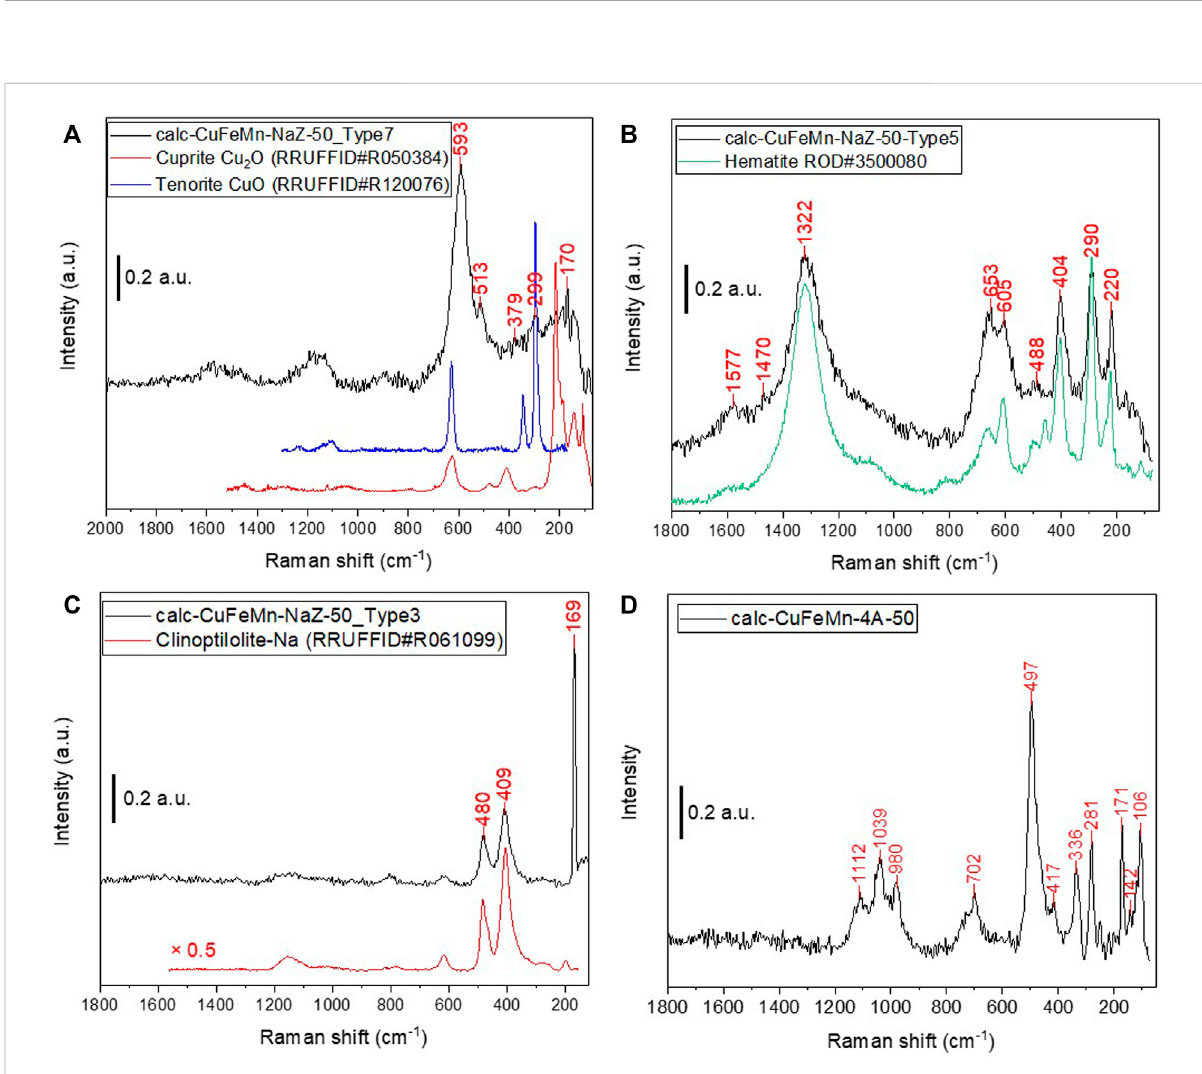
FIGURE 6 Raman spectra of sample calc-CuFeMnNaZ-150 (A,B and C) and sample calc-CuFeMn-4A-50 (D) . Detected peaks are labelled in red while appropriate references are put below spectra in A, B and C. Spectra are vertically translated for clarity.